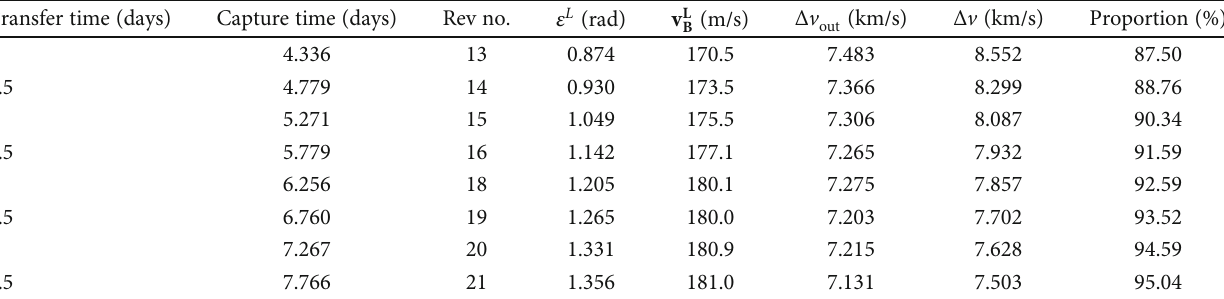
Table 8: Capture parameters of the Earth-Moon transfer trajectory.